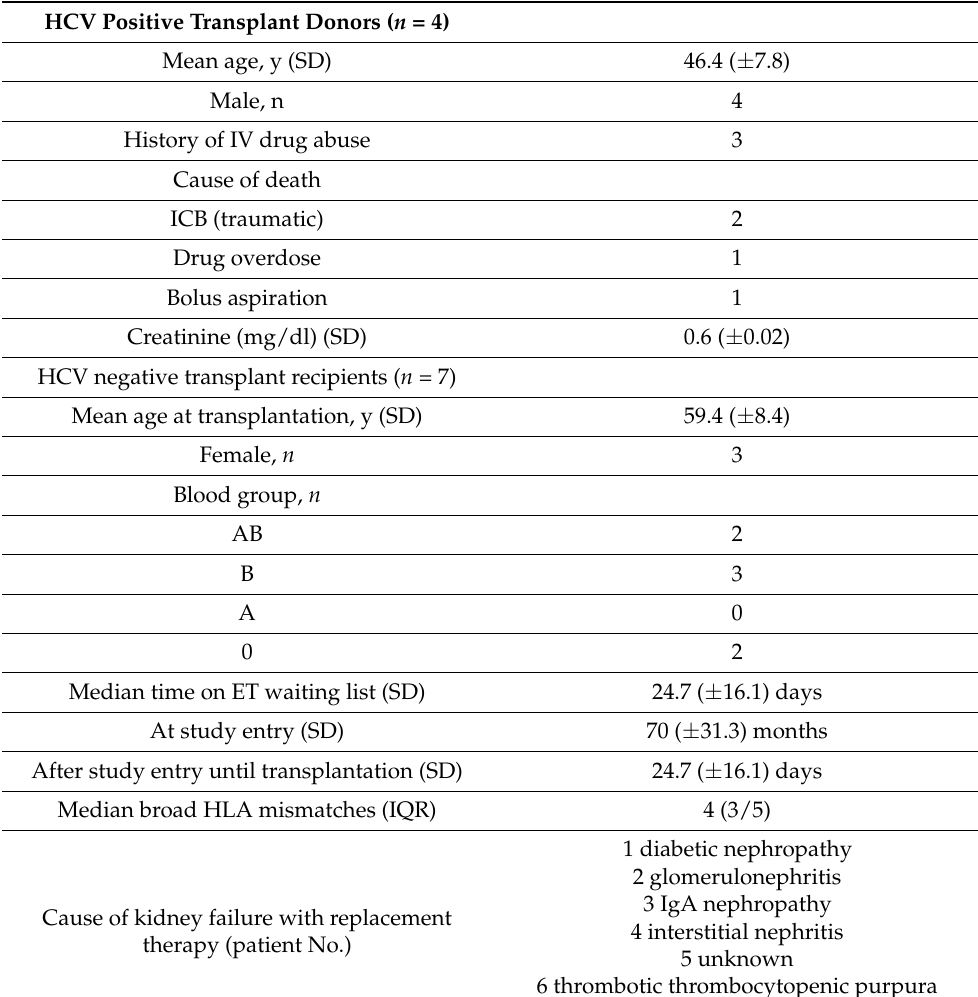
Table 1. Baseline characteristics of HCV positive donors and of HCV negative